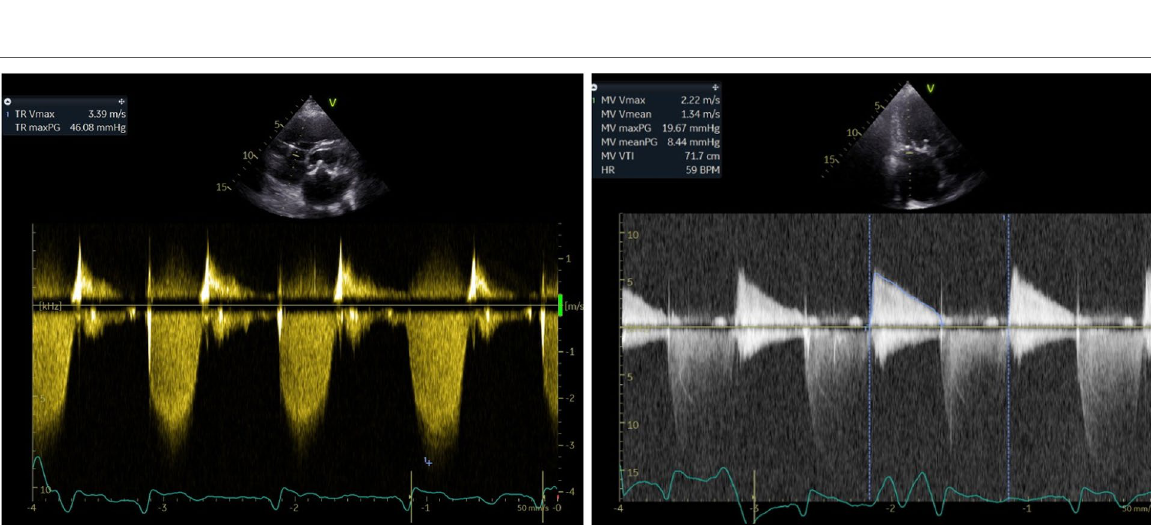
Fig. 2 hemodynamic assessment of the valvular lesion with TTE showed mean gradient over the prthesis of 8 mmHg and moderate pulmonary hypertension (45 mmHG1,8, flow